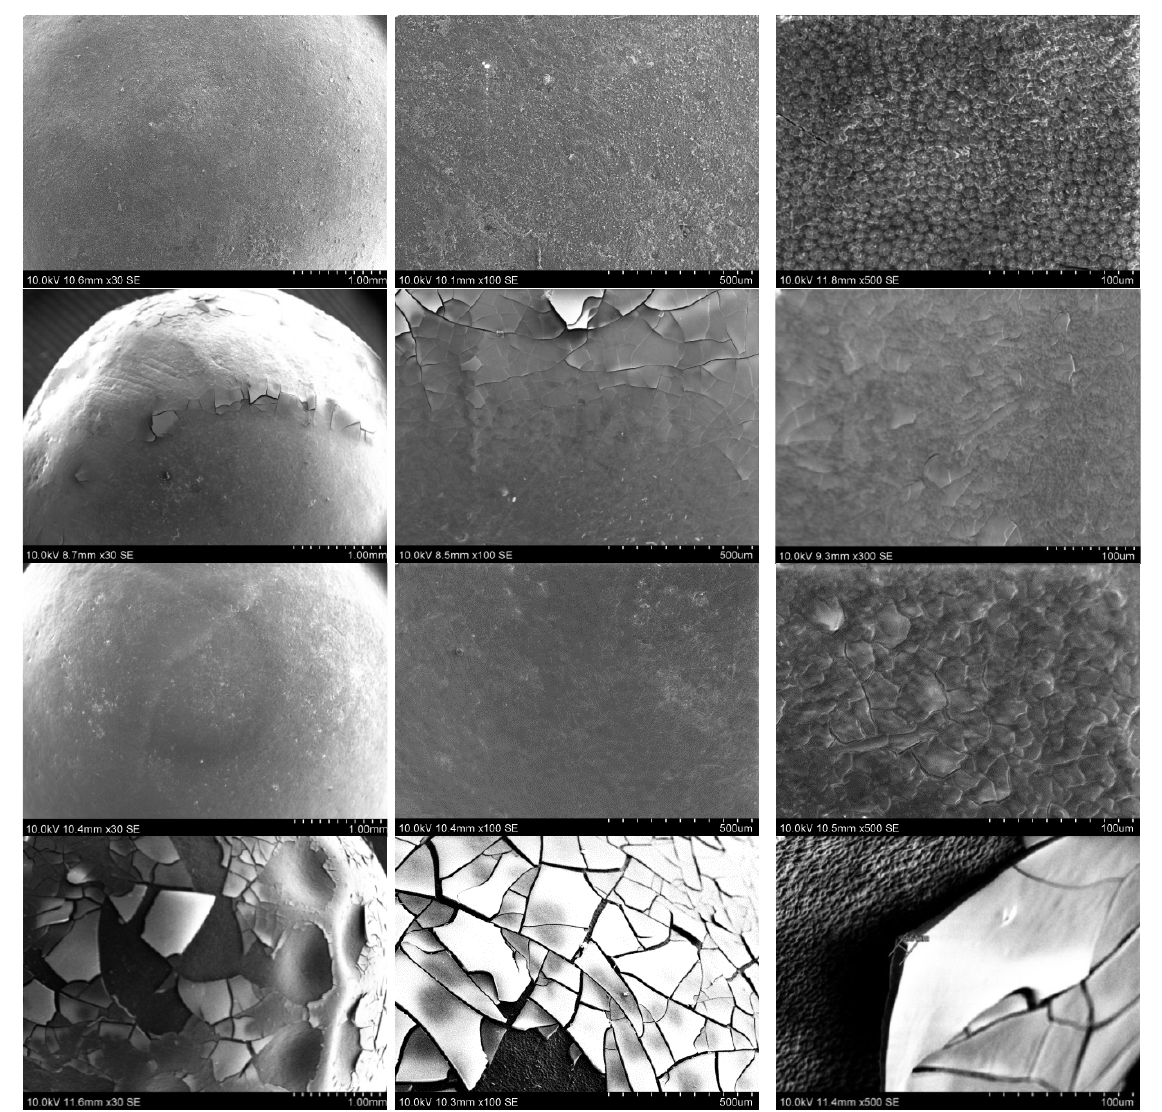
Figure 6. SEM micrographs of the pea seeds not subjected to a germination test: first row—pure seed (without SiO 2 coating); second row—seed with SiO 2 coating; third row—seed with thinner SiO 2 -fertilizer coating; and fourth row—seed with thicker SiO 2 -fertilizer coating.